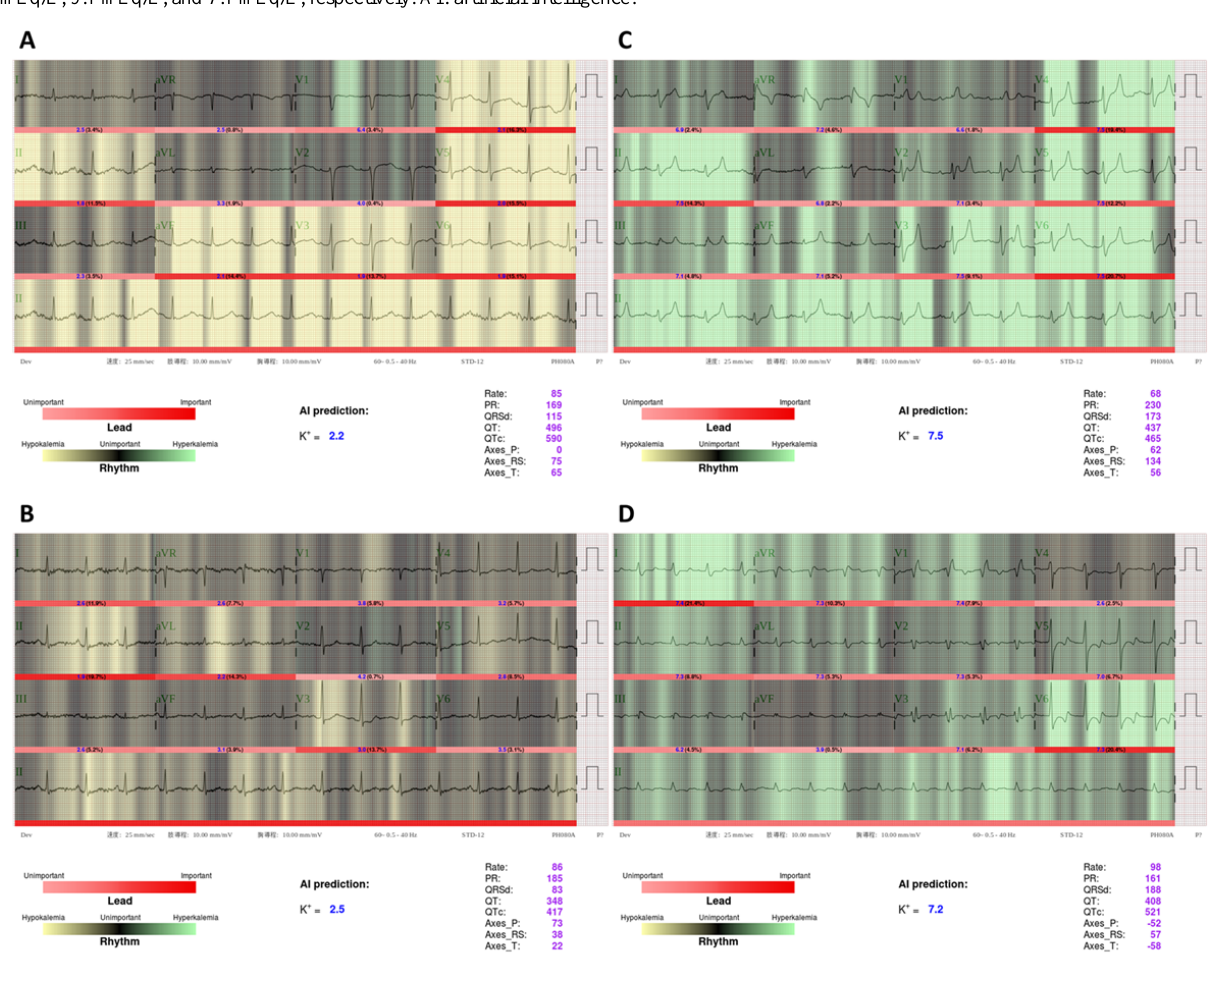
Figure 4. Visualization analysis for ECG12Net-1 in selected severe hypokalemia and hyperkalemia cases. The lighter areas (green or yellow) indicate areas of focus by ECG12Net-1. Clinicians consistently recognized panel A as a typical case of severe hypokalemia but overlooked panel B. Similarly, clinicians consistently recognized panel C as severe hyperkalemia but overlooked panel D. From A to D, the real K + concentrations were 2.3